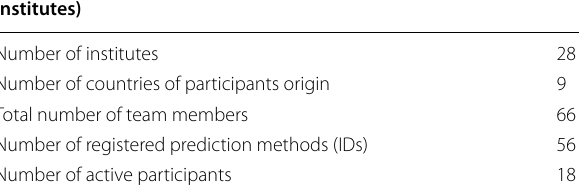
Table 1 Statistics of participants and methods in the 2nd EOP